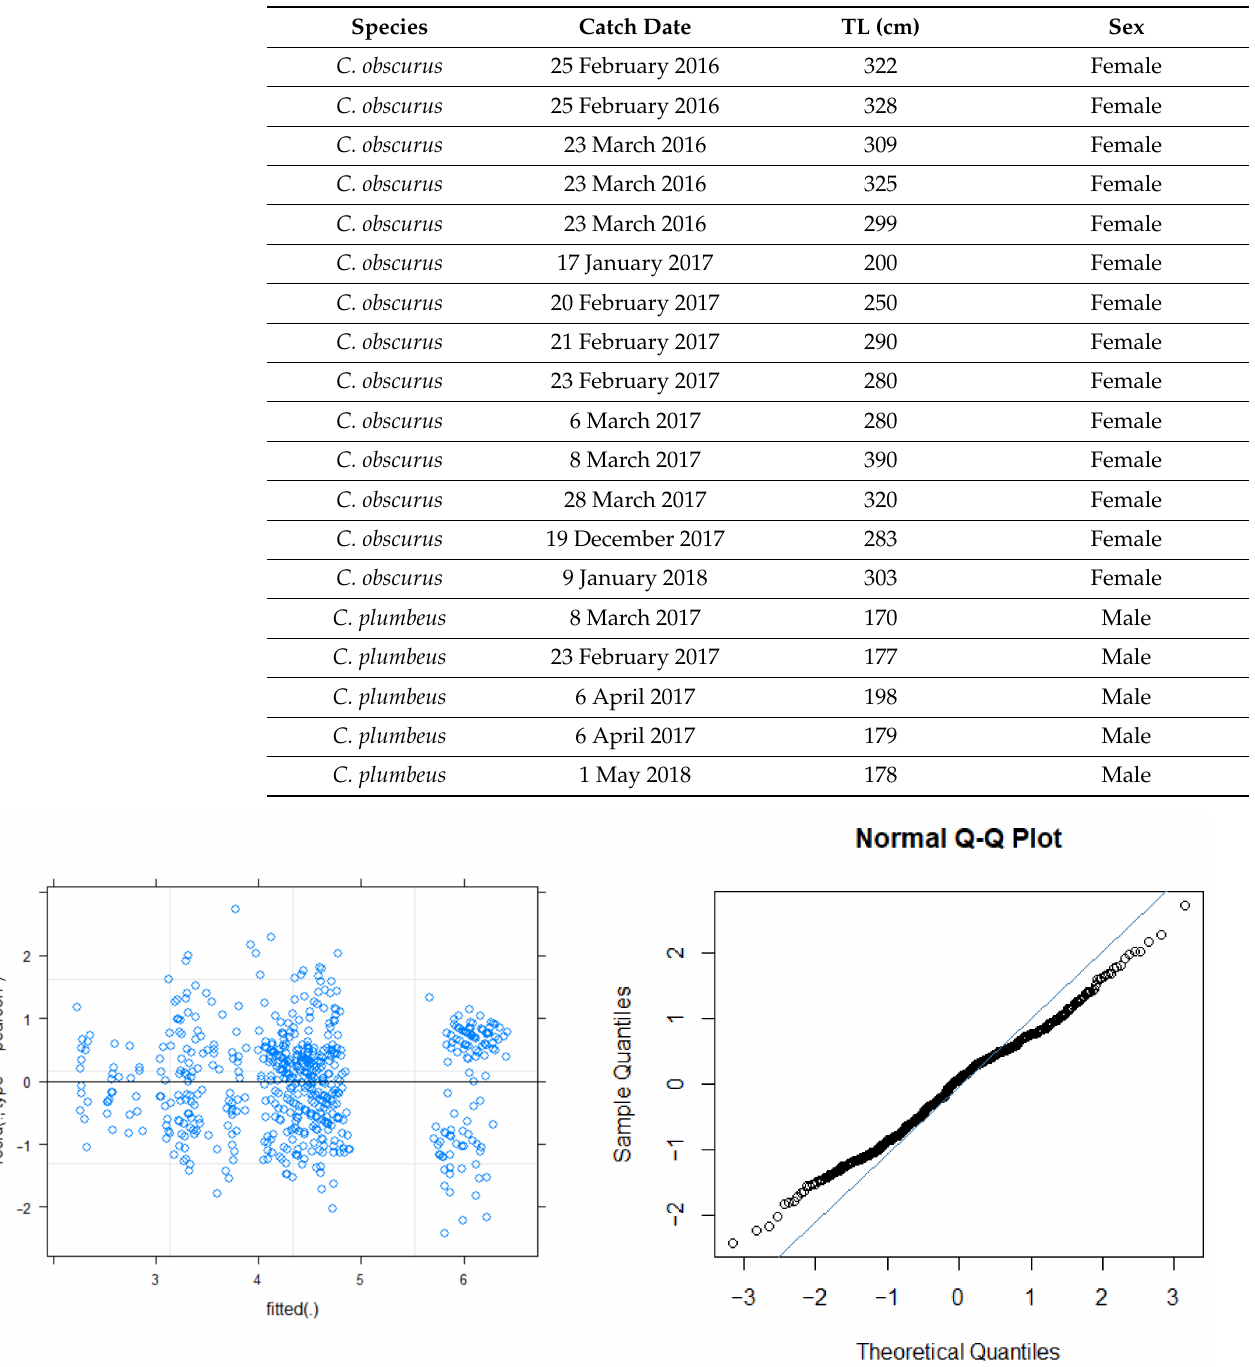
Table A1. Size measurements of untagged sharks captured within the study site between 2016–2017.